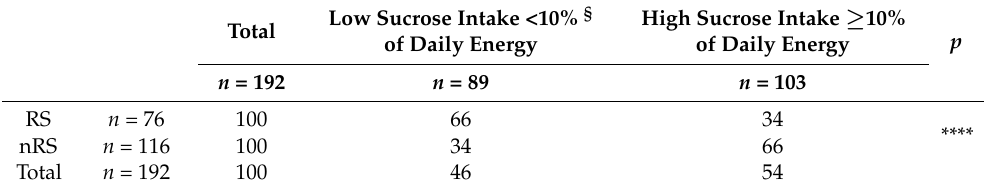
Table 2. Comparison of sample distribution (in %) by low and high sucrose intake.